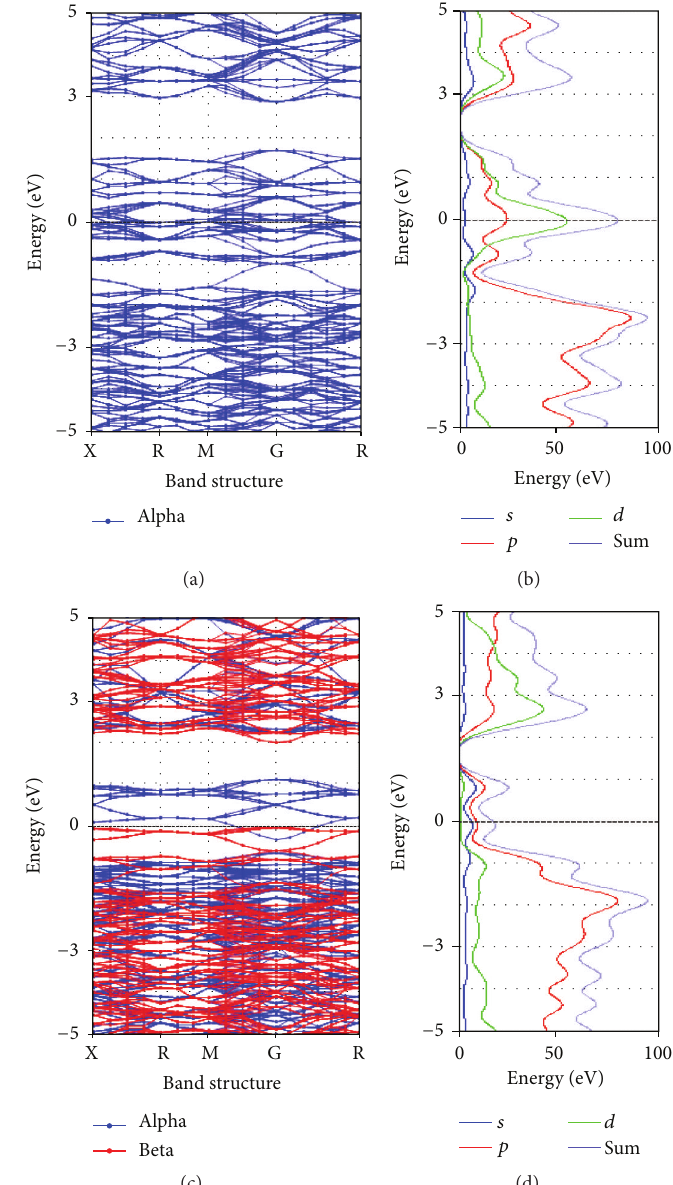
Figure 7: The band structures and DOSs for the cubic BZN random solid solution structure for ((a) and (b)) spin unpolarized and ((c) and (d)) spin polarized